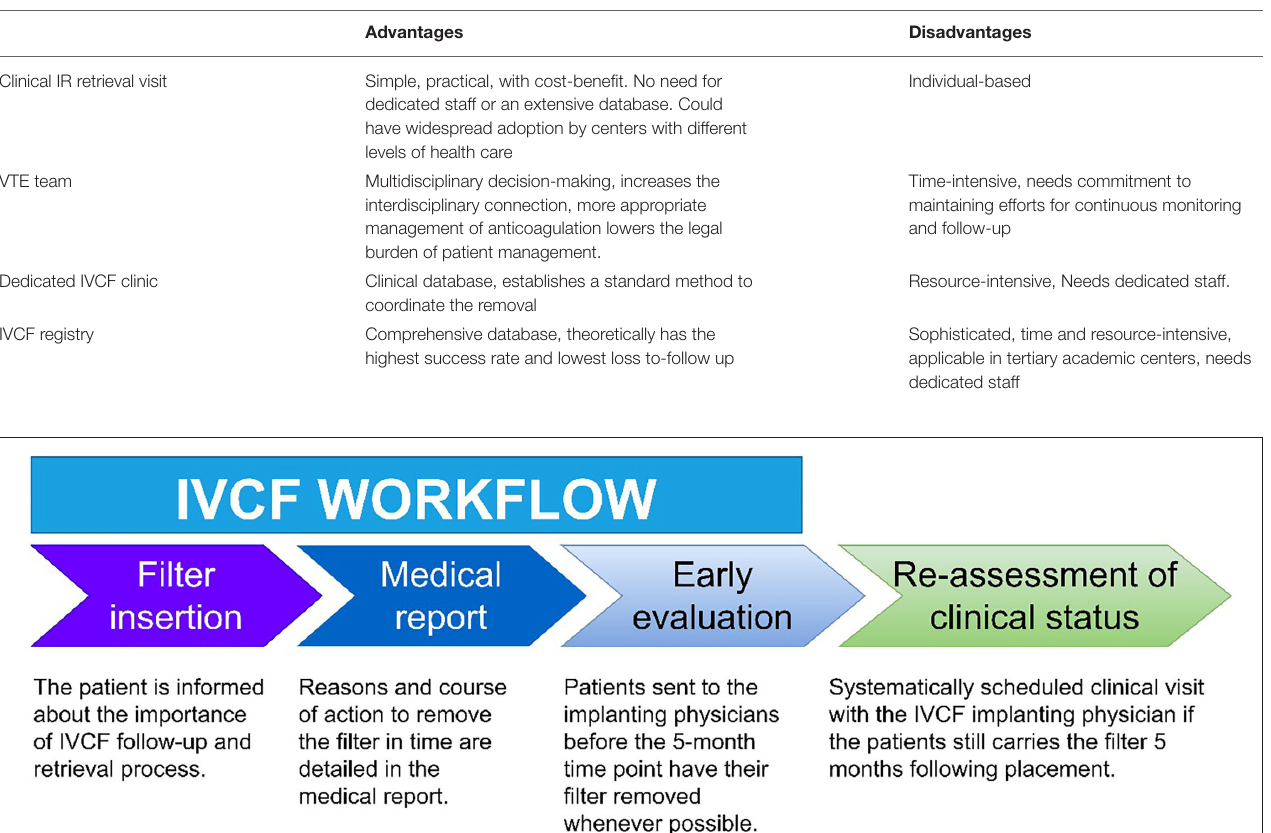
TABLE 4 | IVC filter retrieval strategies, advantages, and